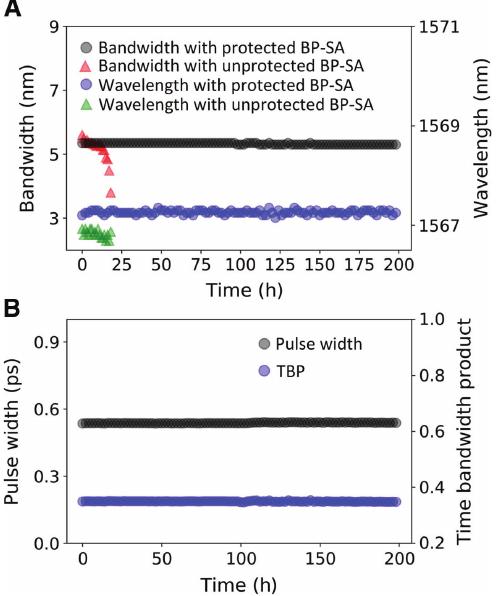
Figure 3: Long-term stability of the BP-SA. Variations of (A) bandwidth and central wavelength under water immersion and (B) pulse width and TBP under water immersion from parylene-C-encapsulated BP-SA